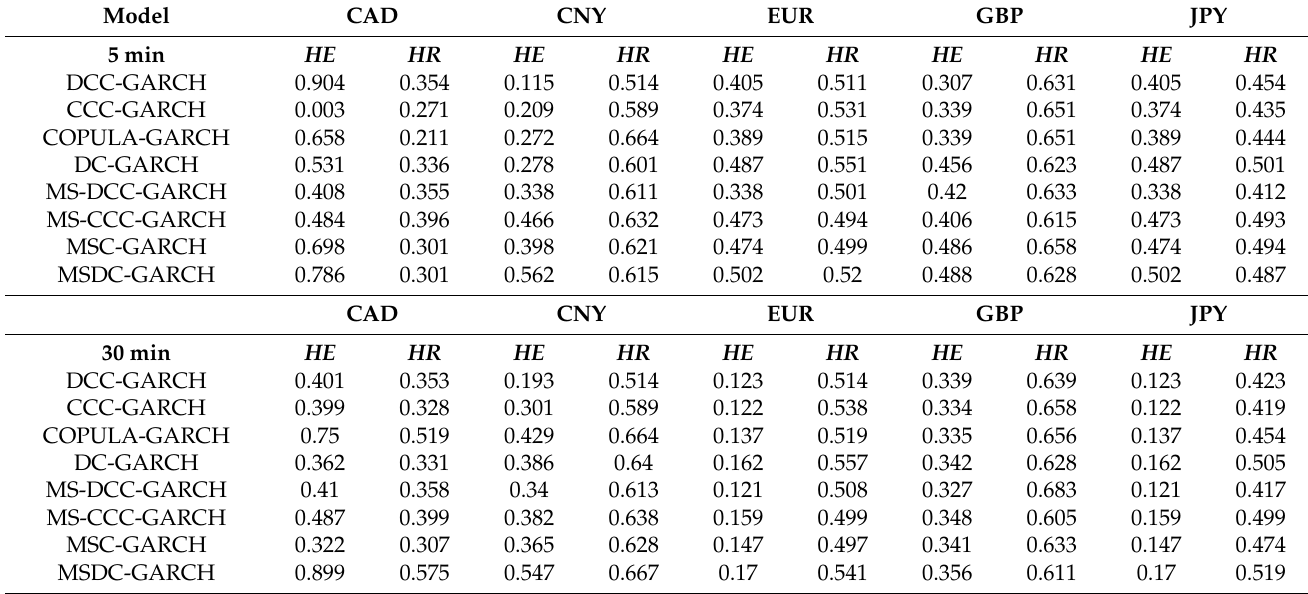
Table 12. The estimated hedging effectiveness (HE) and hedge ratios (HR) through different